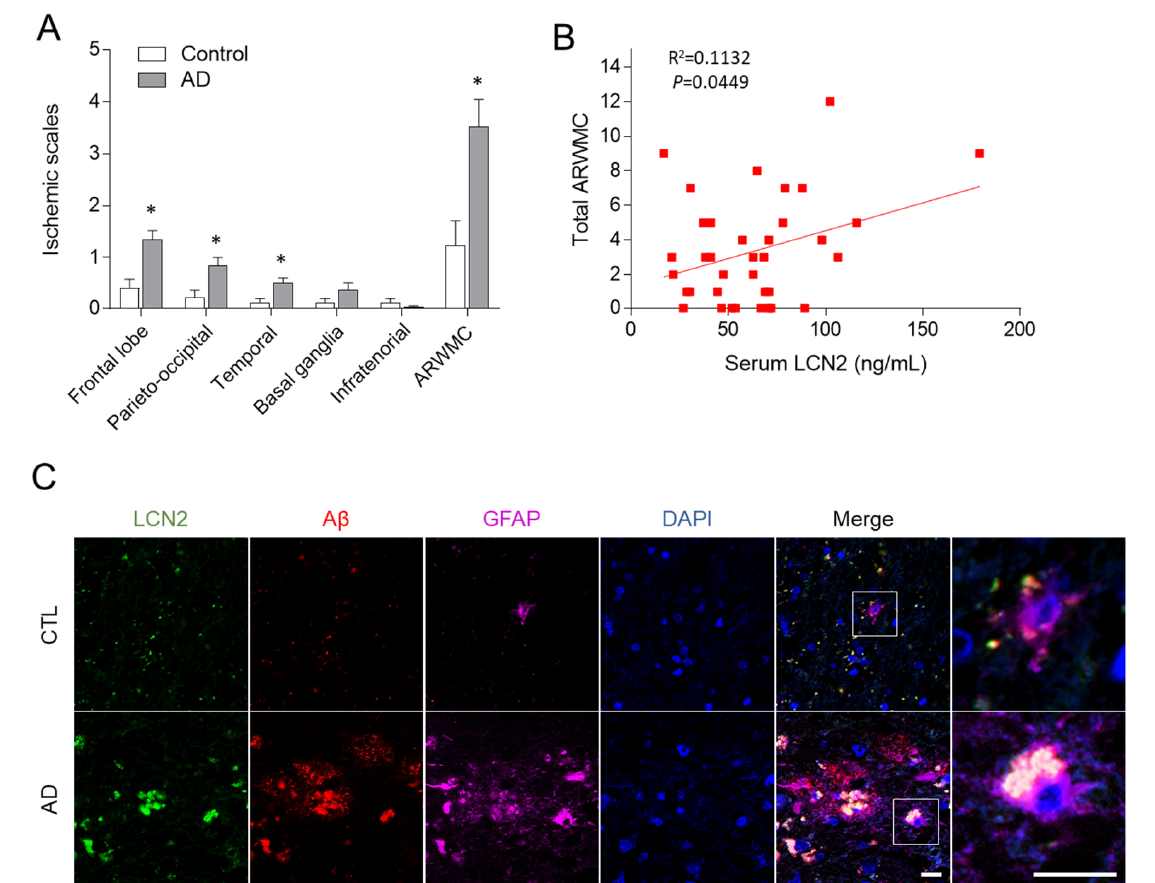
Figure 1. Human LCN2 expression and white matter ischemic changes in AD patients. ( A ) Assessment of ischemic rating scales in control and AD patients. ( B ) Correlation between total ARWMC and serum LCN2 levels in AD patients. ( C ) Representative immunofluorescence images ( × 200) showing LCN2 (green), A β (red), and GFAP (purple) staining in frontal cortex sections from an AD patient. DAPI (blue) was used to stain nuclei. Scale bar = 10 µ m. Data are shown as mean ± SEM. * p < 0.05 versus control (CTL).